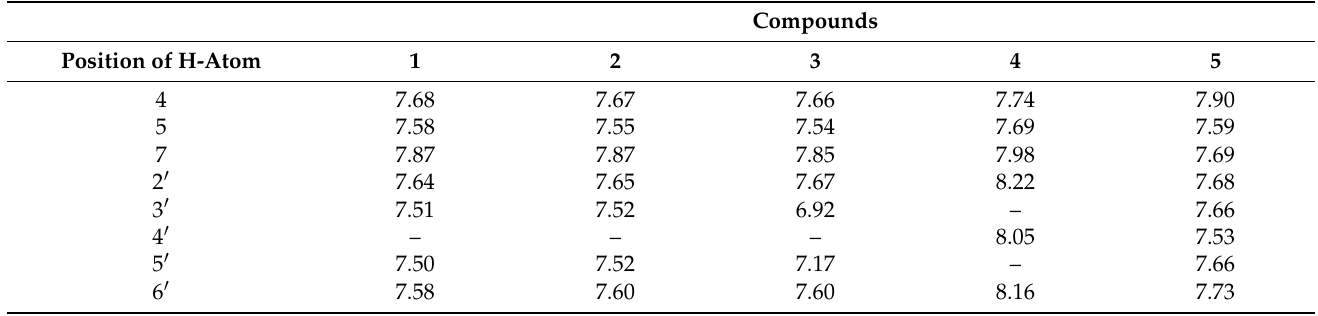
Table 3. The chemical shifts of 1 H and 13 C-NMR calculated with the GIAO method at the B3LYP/6- 311G (d,p)/SMD Chloroform level of